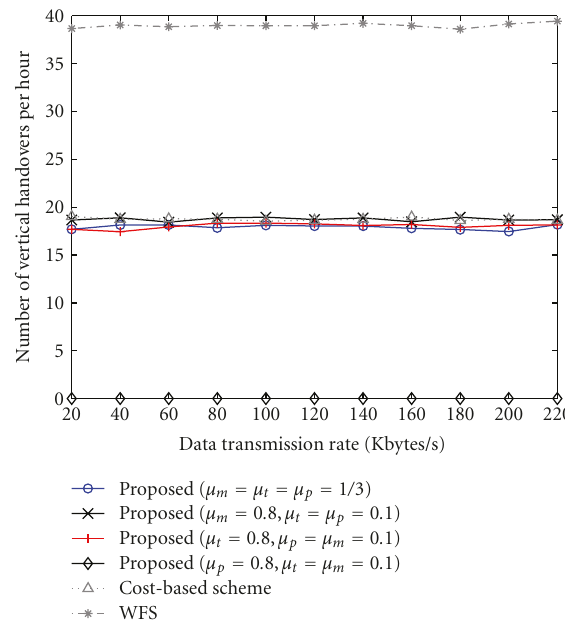
Figure 10: Data transmission rate versus number of VHOs per hour when the UDP tra ffi c ( ρ = 0) is